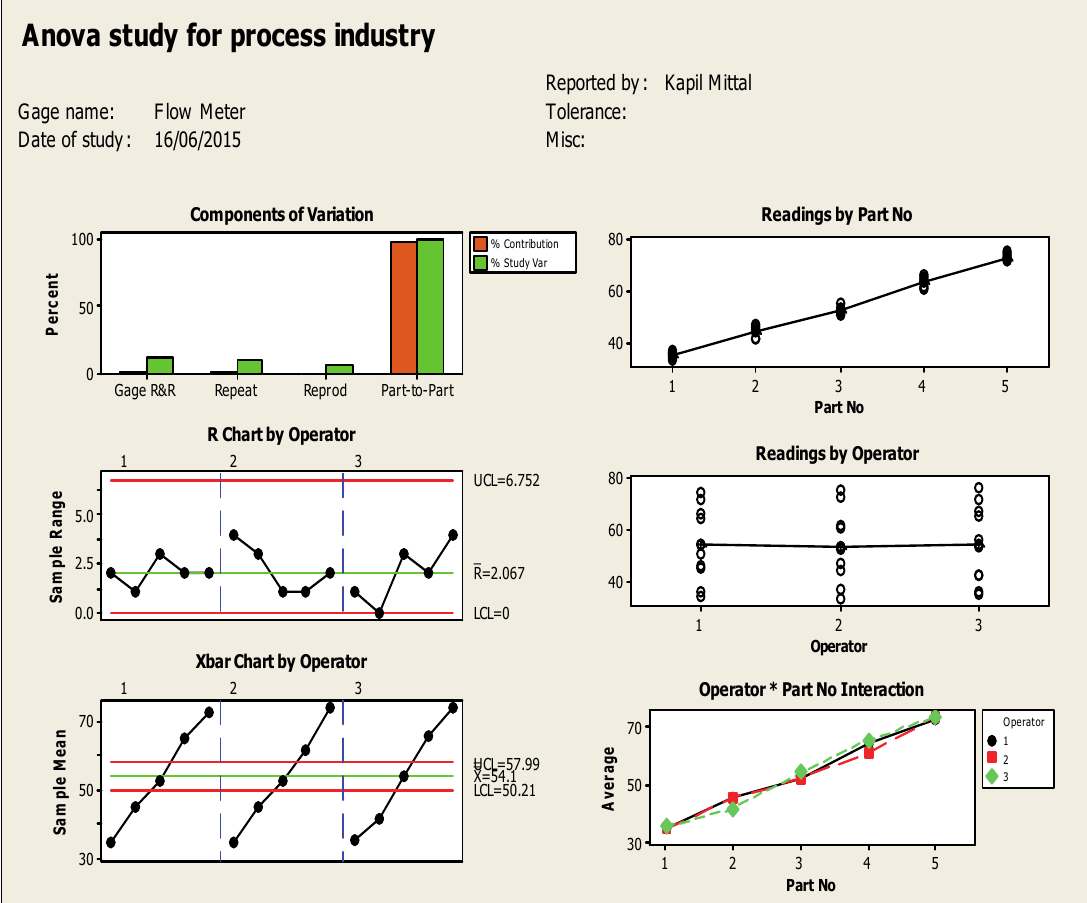
Fig. 5. Components of Variation (Manufacturing